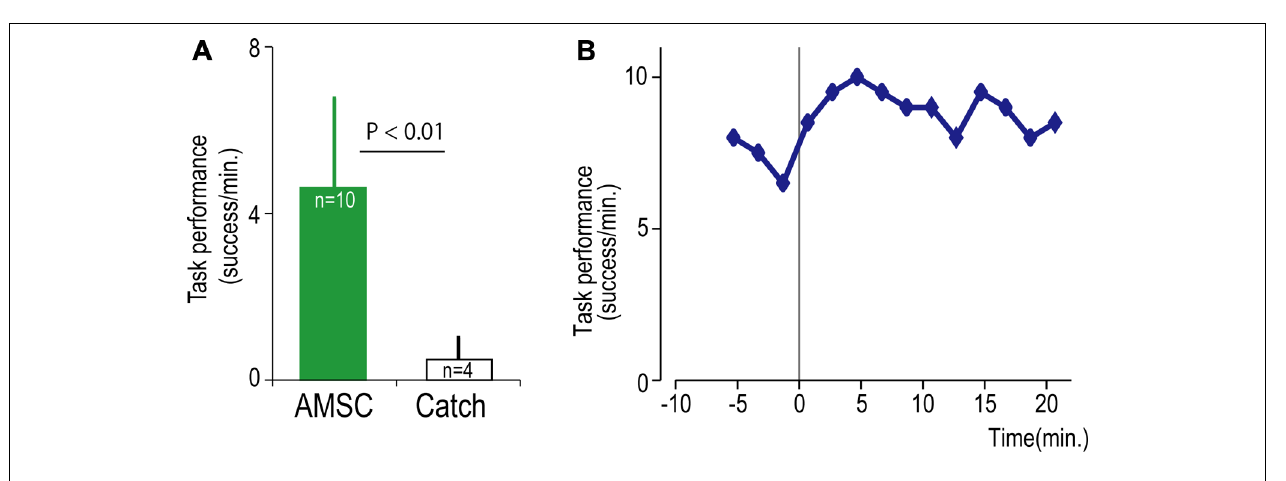
FIGURE 6 |Task performance with the artificial musculospinal connection (AMSC). (A) Average task performance for AMSC and catch trials. Error bars represent standard deviation. (B) Time course of task